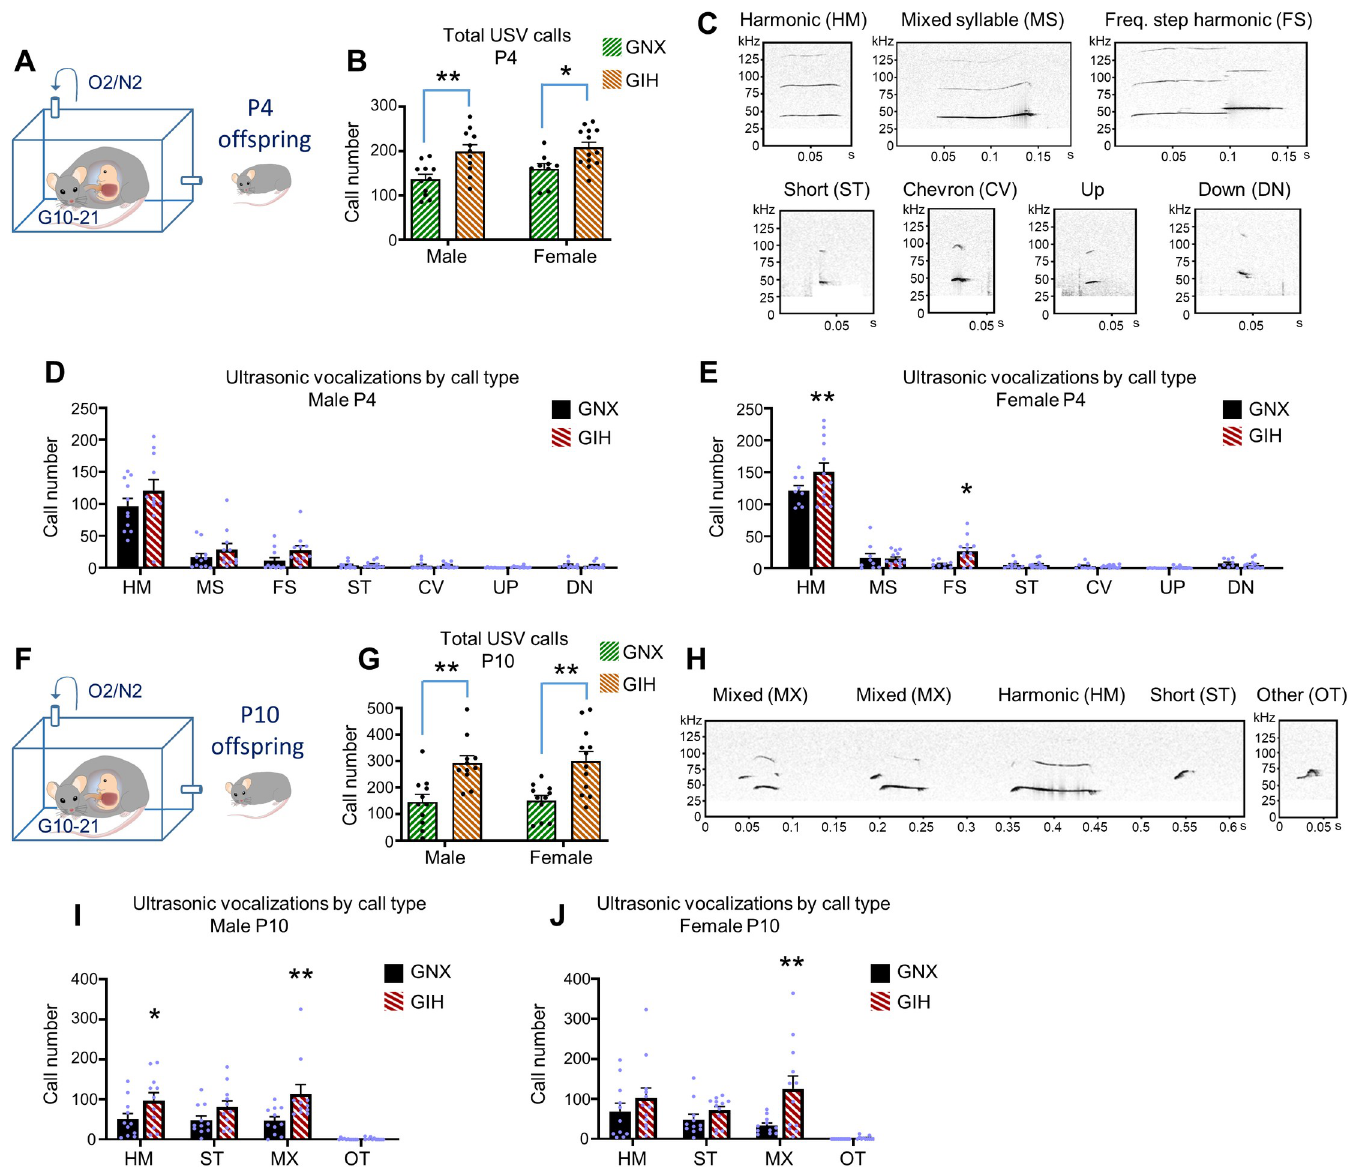
Fig 1. USVs in juvenile offspring of GIH mothers are increased. (A) Schematic depicting GNX and GIH offspring age for data pertaining to Fig 1B–1E . (B) Total USV calls over a 90-second period in P4 male and female GNX and GIH rat offspring. A significant increase in call number was detected in male GIH [Bonferroni post hoc (df,40), p = 0.0023] and female GIH offspring [Bonferroni post hoc (df,40) p = 0.0232] versus sex-matched GNX counterparts. n = 11 male GNX, 11 male GIH, 9 female GNX, 13 female GIH rats. (C) Sample traces of USV subtypes elicited in P4 rats in response to maternal separation. (D) Mean USV subtype calls over a 90-second period in P4 male GNX and GIH offspring rats. No differences in any subtype calls were detected between groups. [False discovery correction post hoc (df, 140): HM, q = 0.082; MS, q = 0.492; FS, q = 0.301; ST, CV, UP, and DN, q = 1.0] n = 11 GNX and 11 GIH rats. (E) Mean USV subtype calls over a 90-second period in P4 female GNX and GIH offspring rats. GIH offspring exhibited a significant increase in number of HM [false discovery correction post hoc (df, 140) q = 0.0013] and FS [false discovery correction post hoc (df,140) q = 0.0231] calls relative to GNX offspring [MS, ST, CV, UP, and DN (df,140) q = 0.7302]. n = 9 GNX and 13 GIH rats. (F) Schematic depicting offspring age for data pertaining to Fig 1G–1J . (G) Total USV calls in P10 male and female GNX and GIH offspring rats over a 90-second period in response to maternal separation. A significant increase in call number was detected in male [Bonferroni post hoc (df,41) p = 0.0017] and female [Bonferroni post hoc (df,41) p = 0.0011] GIH offspring versus sex-matched GNX counterparts. n = 11 male GNX, 11 male GIH, 11 GNX female, 12 GIH female rats. (H) Sample traces of USV subtypes in P10 rats in response to maternal separation. (I) Mean USV subtype calls over a 90-second period in P10 male GNX and GIH offspring rats. GIH offspring exhibited a significant increase in the number of HM [false discovery correction post hoc (df,80) q = 0.0392] and MX [false discovery correction post hoc (df,80) q = 0.0051] calls relative to GNX offspring [ST (df,80) q = 0.1167; OT (df,80) q = 0.7623]. n = 11 GNX and 11 GIH rats. (J) Mean USV subtype calls over a 90-second period in P10 female GNX and GIH offspring rats. GIH offspring exhibited a significant increase in the number of MX calls [false discovery correction post hoc (df,84) q = 0.0016] relative to GNX offspring [HM (df,84) q = 0.3065; ST (df,84) q = 0.3953; OT (df,84) q = 0.7299]. n = 11 GNX and 12 GIH rats. All bar graphs are the mean + SEM. The data underlying this figure can be found in S1 Raw Data. CV, chevron; DN, down; FS, frequency step harmonic; GIH, gestational intermittent hypoxia; GNX, gestational normoxia; HM, harmonic; MS, mixed syllable; OT, other; P4, postnatal day 4; P10, postnatal day 10; ST, short; USV, ultrasonic